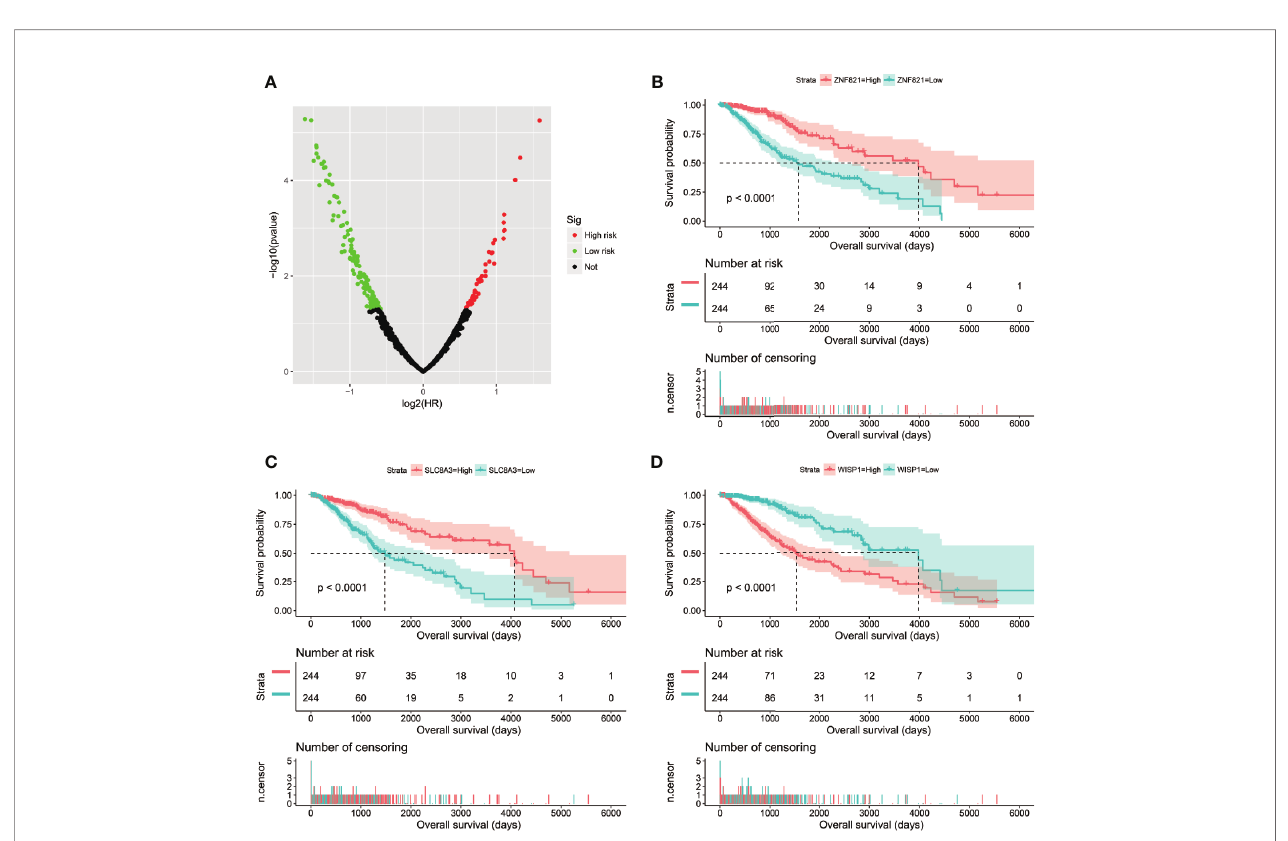
FIGURE 6 | Survival analysis results of snoRNAs co-expressed PCGs in TCGA LGG cohort. (A) Volcano plot of snoRNAs co-expressed PCGs survival analysis results; (B) Kaplan – Meier survival curves of ZNF821; (C) Kaplan – Meier survival curves of SLC8A3; (D) Kaplan – Meier survival curves of WISP1.